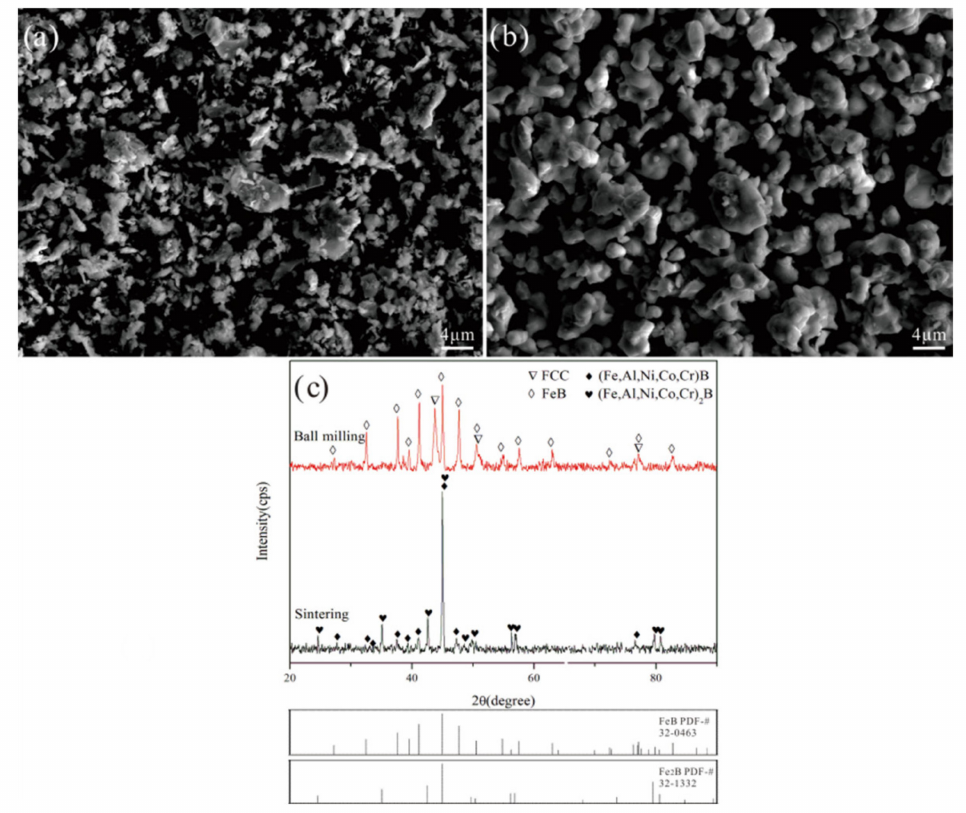
Figure 3. Morphologies and phase compositions of FeB-30 wt.% Al 0.25 FeNiCoCr powders after ball milling and vacuum sintering: ( a ) ball milling, ( b ) vacuum sintering, and ( c ) phase